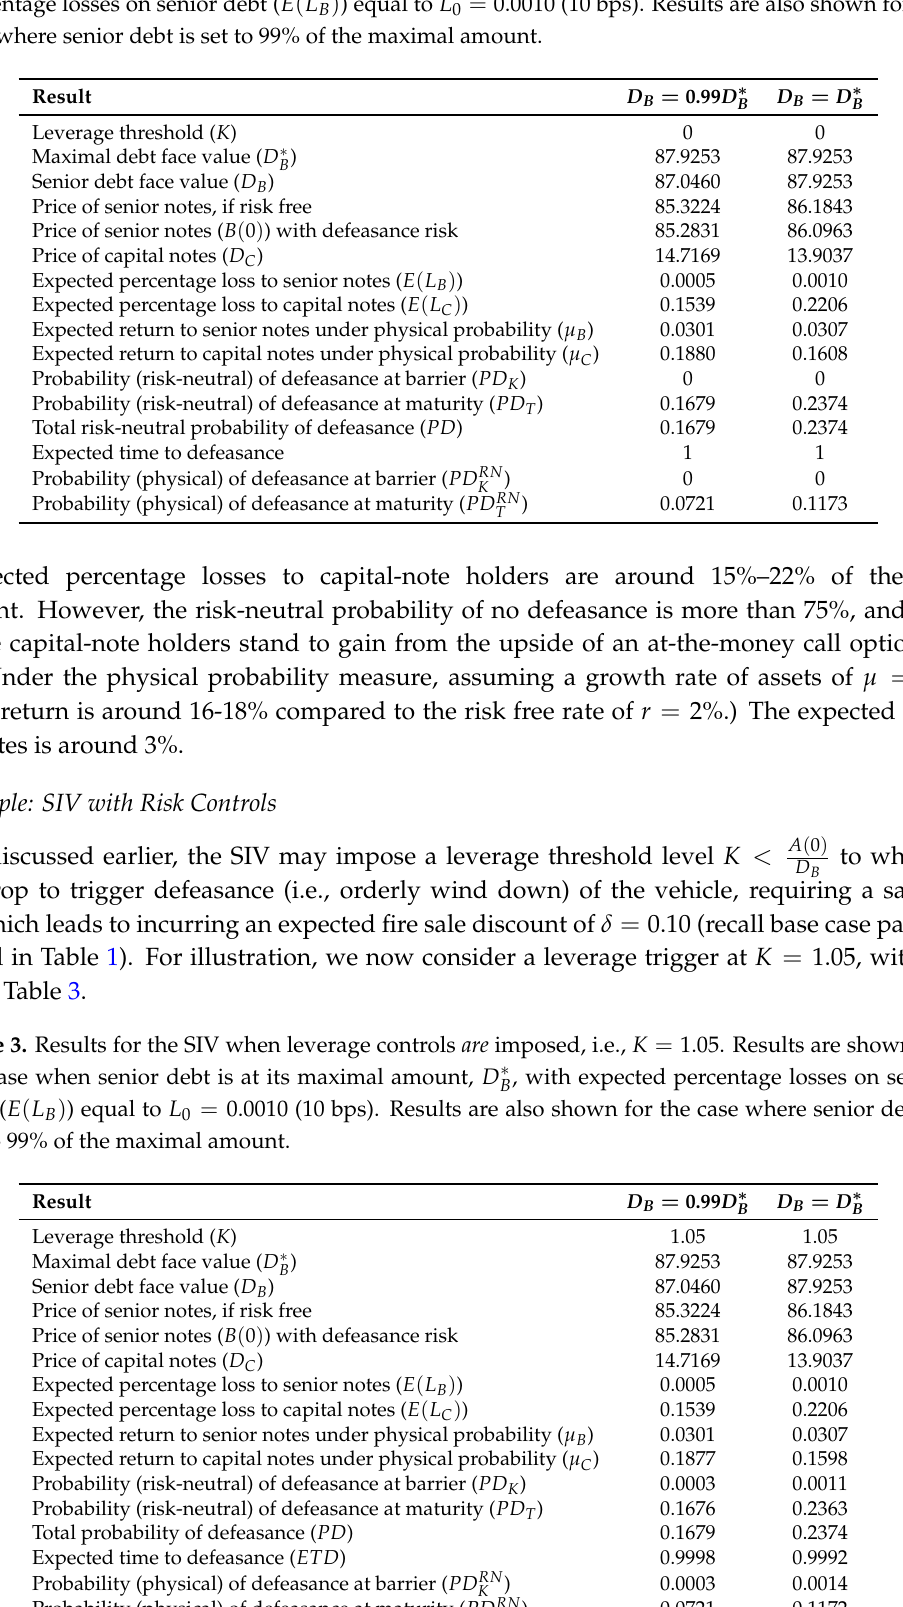
, with expected B